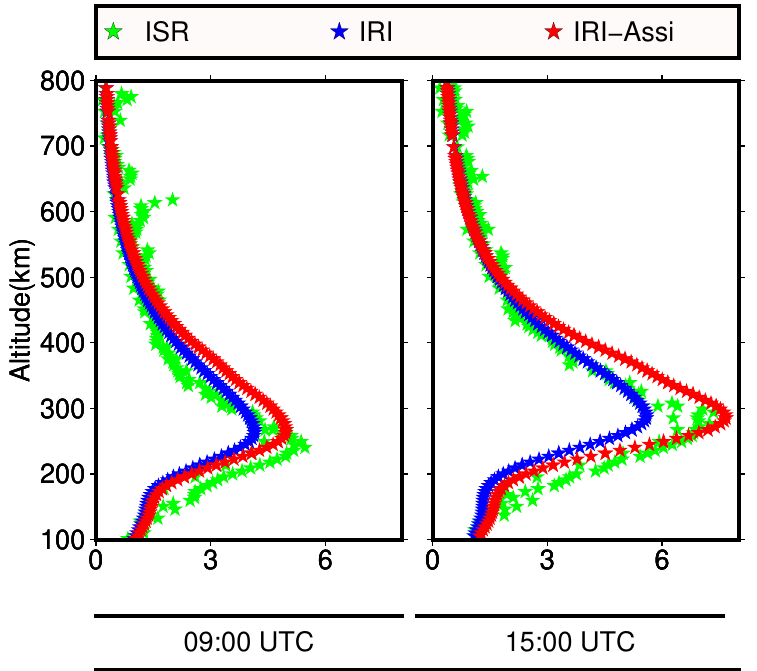
Figure 13. Electron density profiles (EDP) of the ISR and ionospheric models of Millstone: ( left ) EDP at 09:00 UTC; ( right ) EDP at 15:00